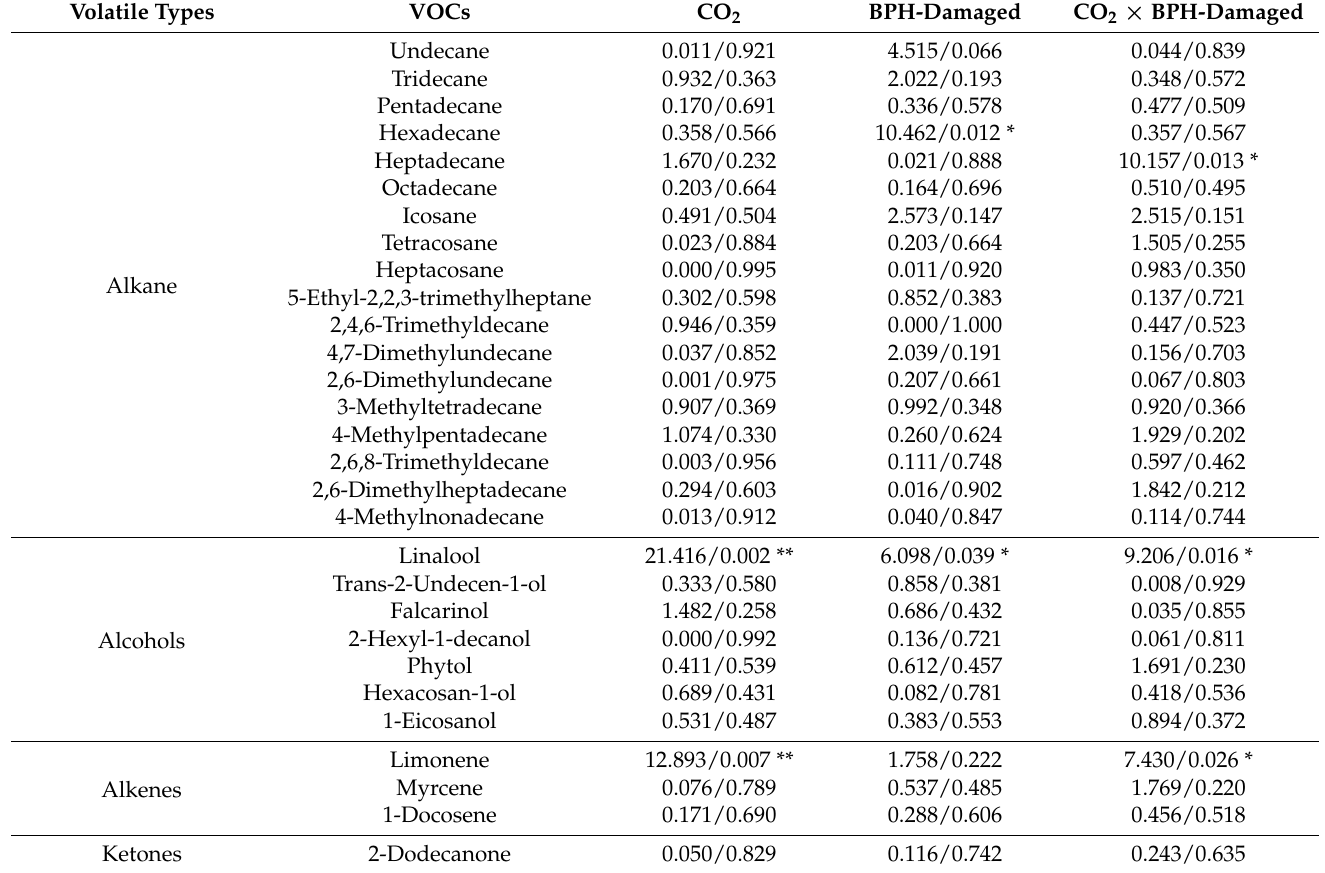
Table 3. Two-way ANOVAs on the effects of CO 2 level (ambient CO 2 versus elevated CO 2 ), damaged treatment and their interaction on the percent of each kind of volatile organic compounds (VOCs) from the healthy (CK) and BPH-damaged rice plants grown under ambient and elevated CO 2 ( F/p values). BPH-Damaged CO 2 ×